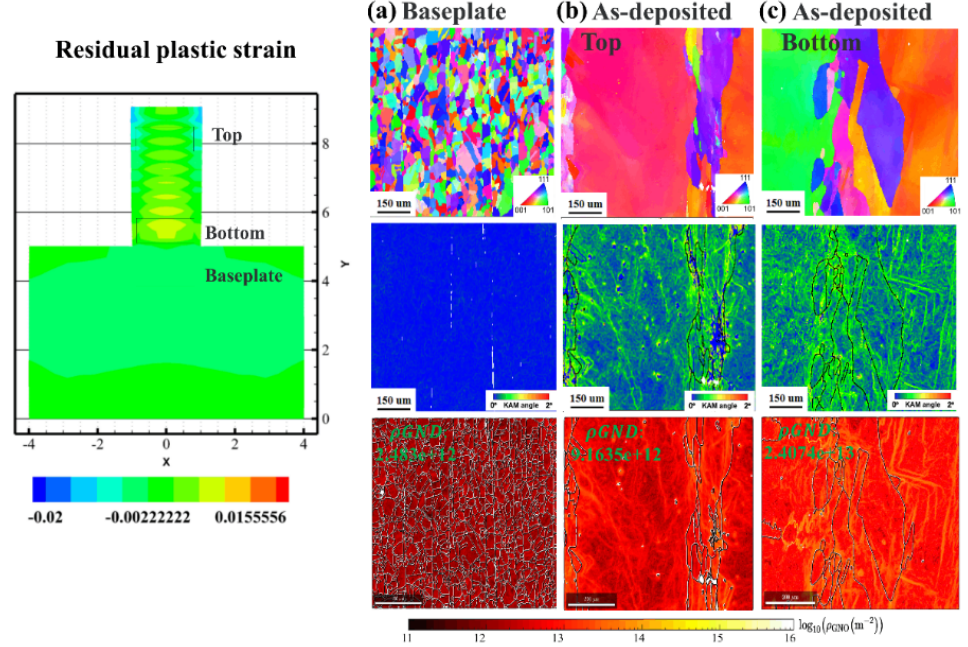
Figure 12. EBSD-analyzed strain images of different zones and the geometrically necessary dislocation (GND) density mapping of ( a ) the baseplate zone; ( b ) the top zone; and ( c ) the bottom zone.